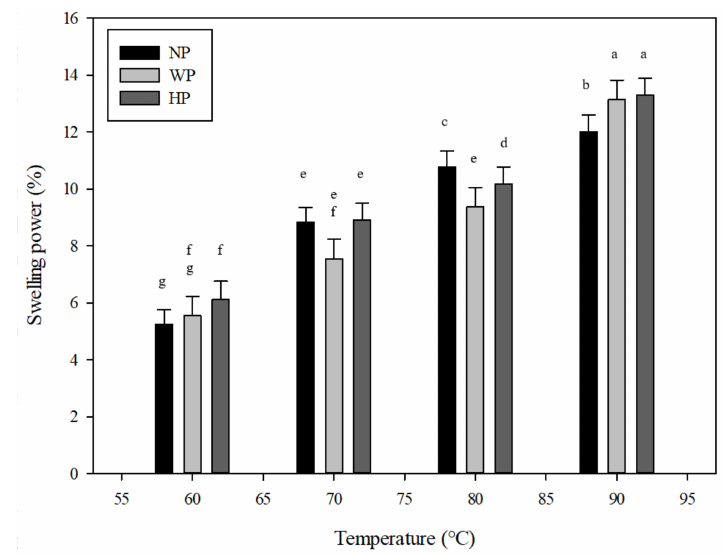
Figure 3. Swelling power of djulis starch by the (1) hydrochloric acid isolation procedure (HP); (2) deionized water isolation procedure (WP); and (3) sodium hydroxide isolation procedure (NP) for djulis starch. Means with the same letters in a column do not di ff er significantly ( p < 0.05) ( n =